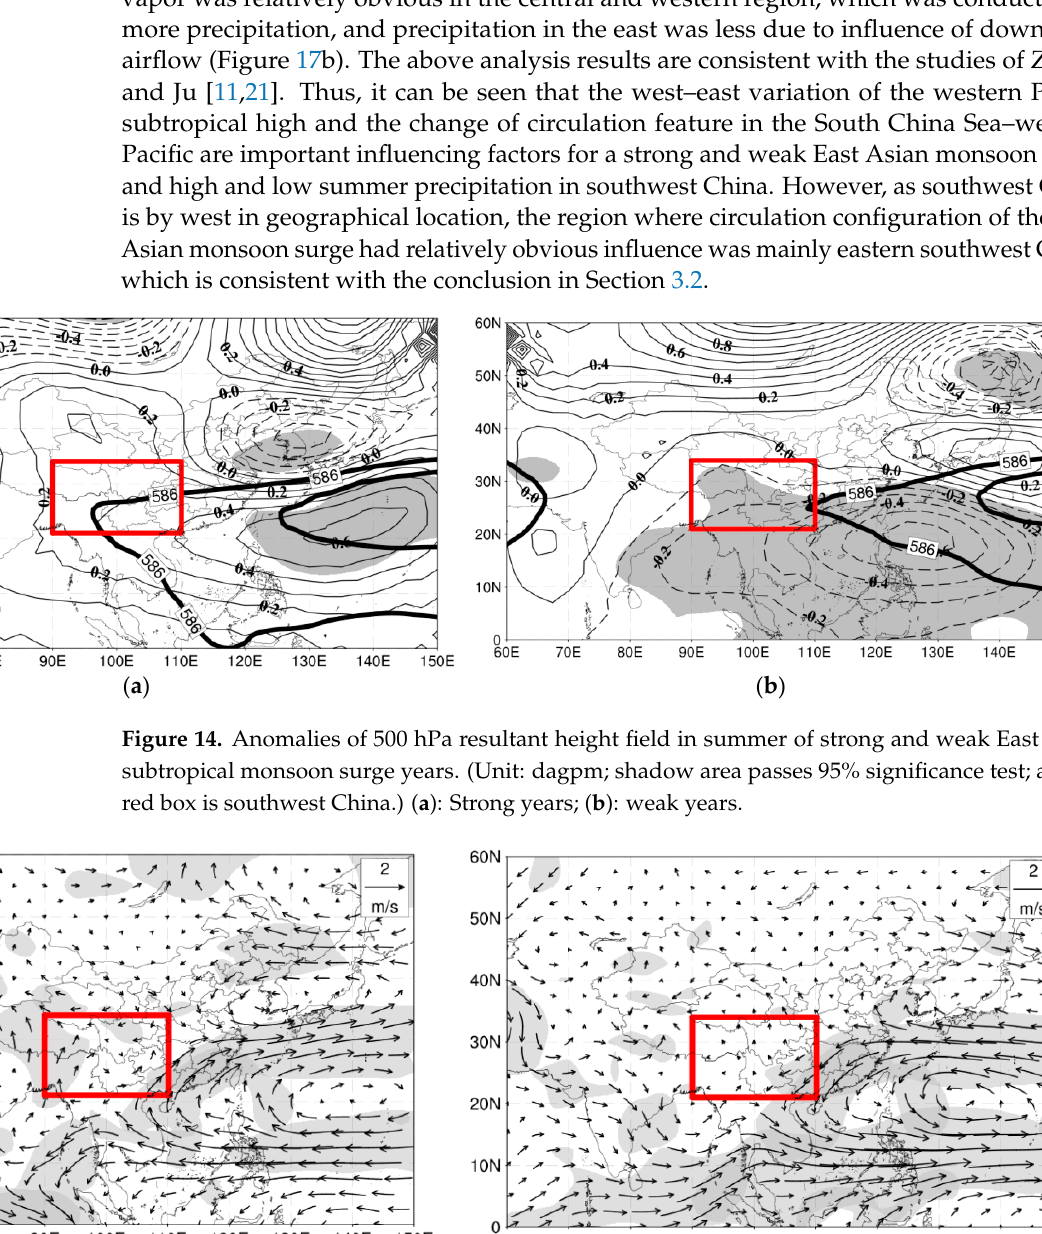
Figure 15. Anomalies of 850 hPa resultant wind field in summer of strong and weak East Asian subtropical monsoon surge years. (Unit: m·s − 1 ; shadow area passes 95% significance test; area in red box is southwest China.) ( a ): Strong years; ( b ): weak years.